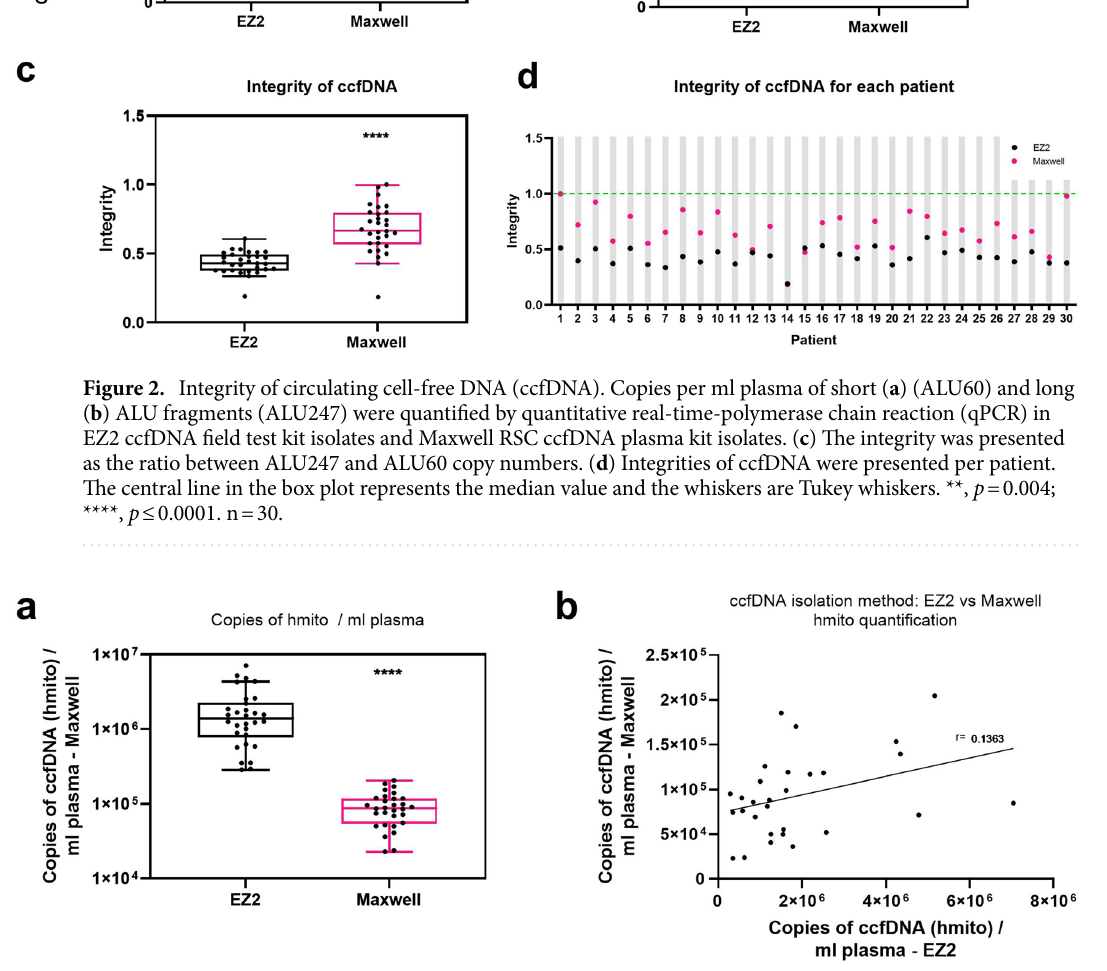
Figure 3. Copies of circulating mitochondrial DNA fragments (hmito). ( a ) Copies of hmito fragments per ml plasma were quantified by quantitative real-time polymerase chain reaction (qPCR) in samples isolated using the EZ2 ccfDNA field test kit or the Maxwell RSC ccfDNA plasma kit. ( b ) Copies of hmito isolated using the EZ2 ccfDNA field test kit were correlated with the copy numbers of hmito fragments in samples isolated with the Maxwell RSC ccfDNA plasma kit. The solid black line indicates the linear regression observed. The central line in the box plot represents the median value and the whiskers are Tukey whiskers. ****, p ≤ 0.0001. n =